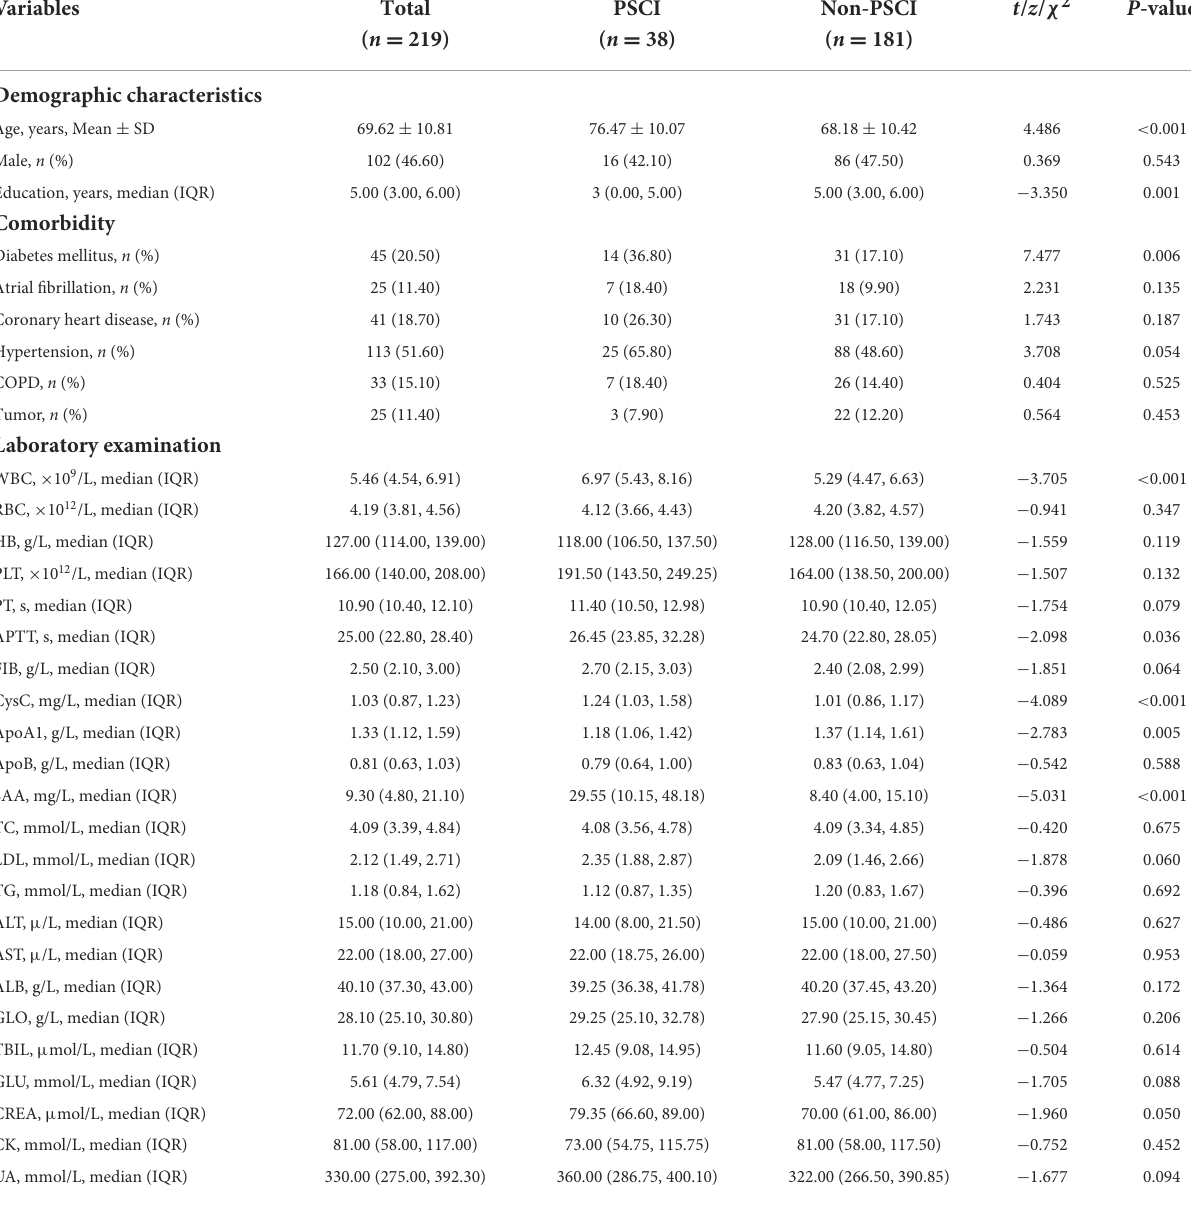
TABLE 2 Baseline and clinical characteristics of lacunar infarction patients in the training set.